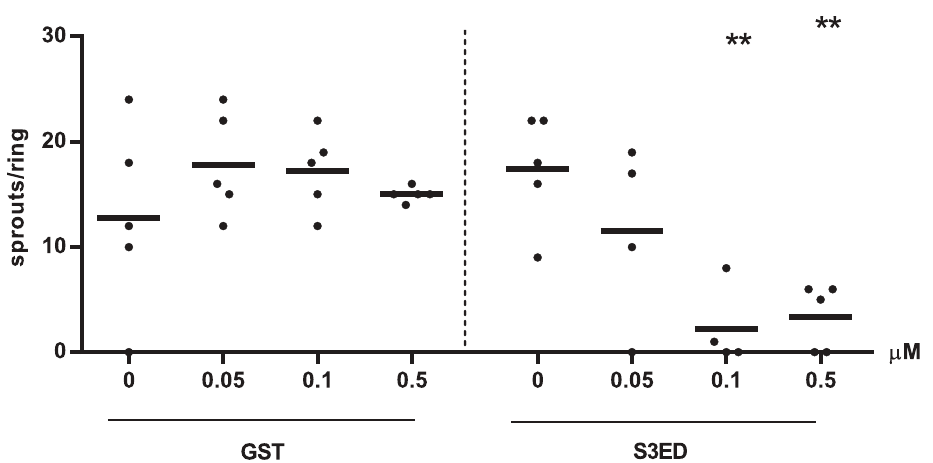
Figure 3. The anti-angiogenic effect of S3ED is dose dependant. Rat aortic rings were embedded in Collagen I with the indicated concentrations of either GST or S3ED in the presence of VEGF. Angiogenic sprouts were counted 4 days after seeding. Data is from 5 rings per condition. One-way ANOVA with Bonferroni multiple comparisons was used to compare S3ED 0.5 µM to S3ED 0 µM considered as a control.